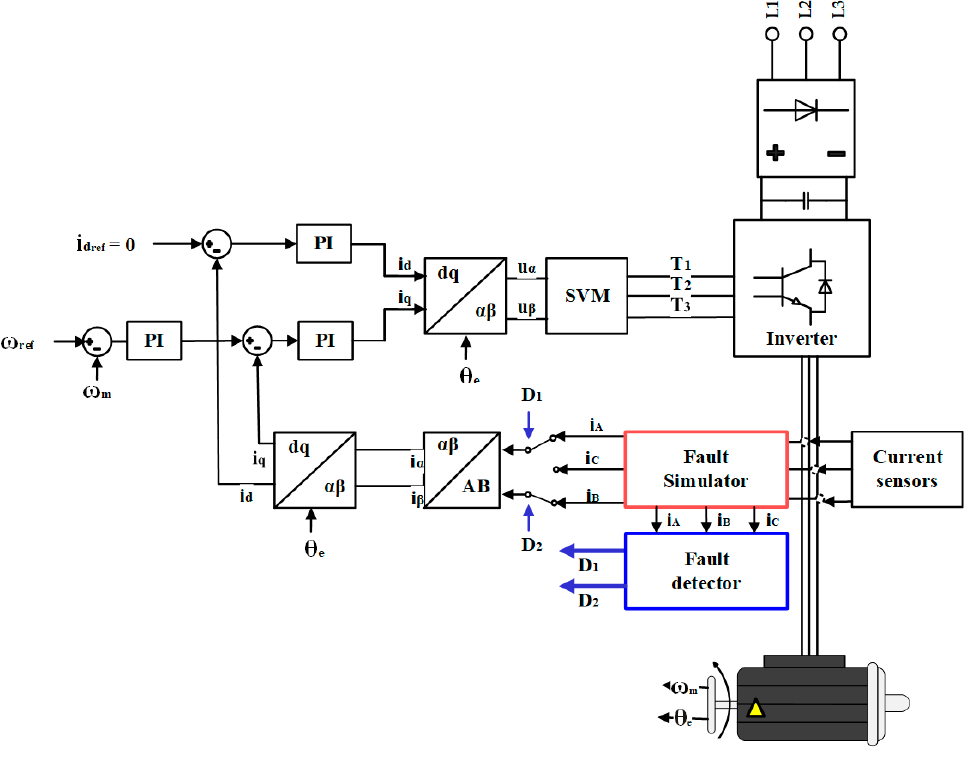
Figure 1. Block diagram of the control structure.